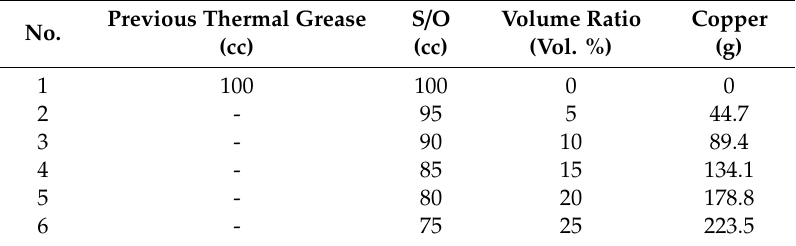
Table 2. Manufacturing conditions of thermal